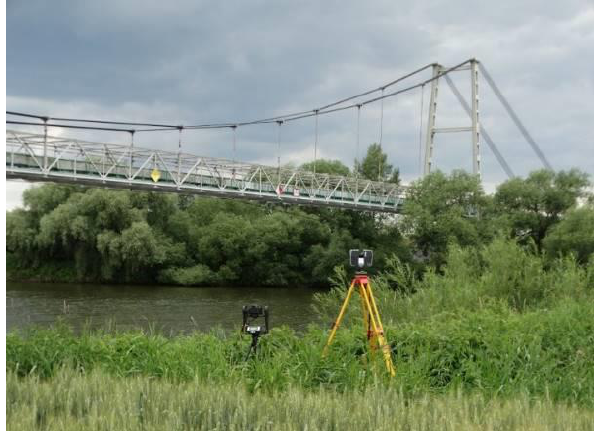
Figure 8. Side view of the bridge measurement sets for laser scanning and photogrammetry.